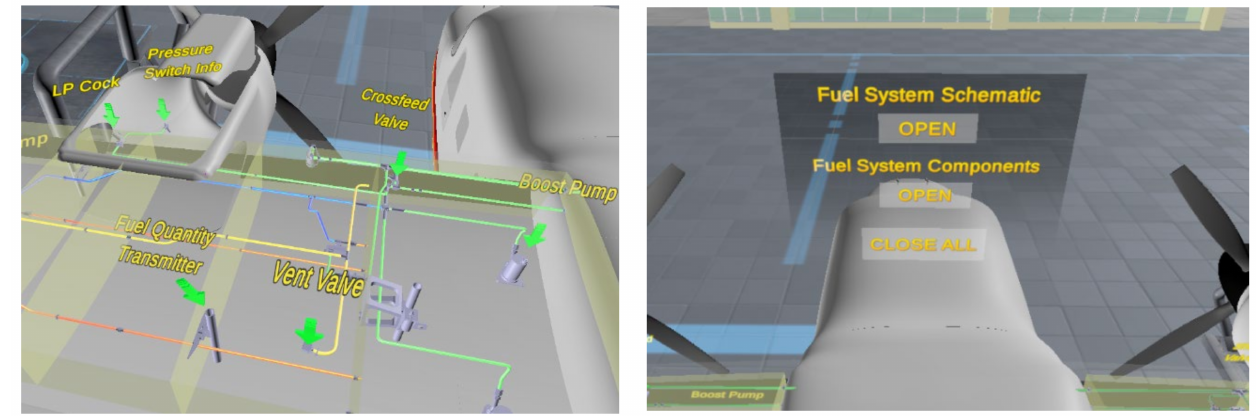
Figure 5. Fuel system observation scene. The green arrow indicates parts location of fuel system.